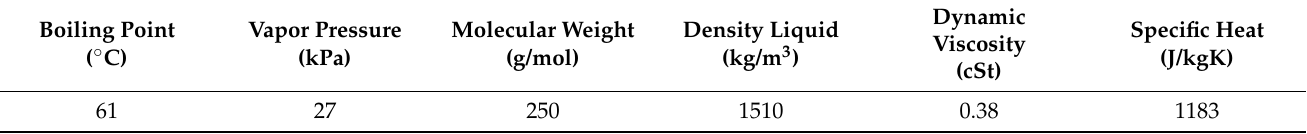
Table 2. Operating conditions and experimental results.